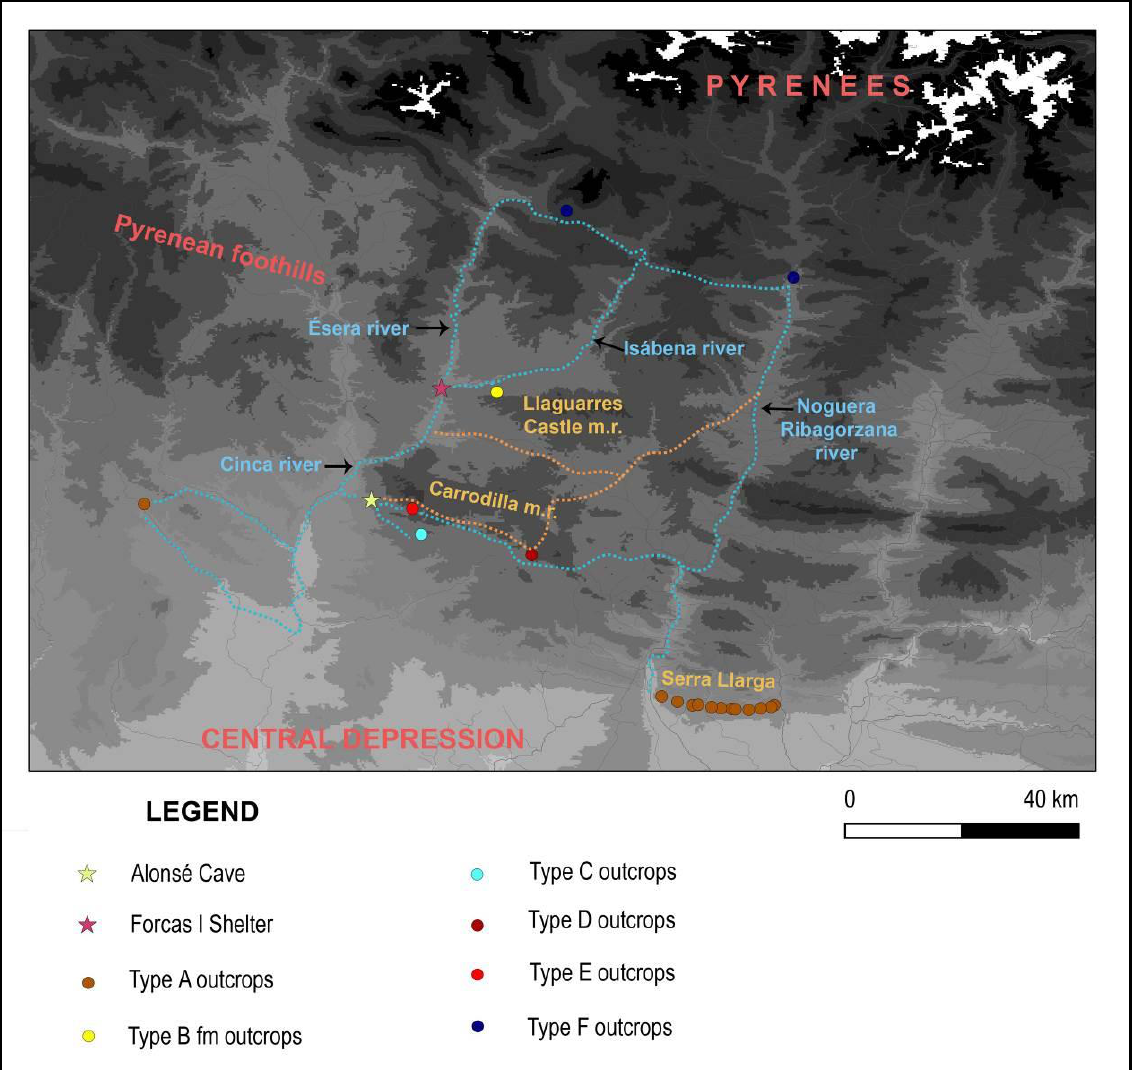
Figure 8. Alonsé Cave and Forcas I Shelter and the different geological formations with parallels in the archaeological record. In blue, most suitable routes to connect the chert outcrops with the archaeological sites taking into account the rivers axis. In brown, proposed route to avoid the narrow passes of the river and go directly to the